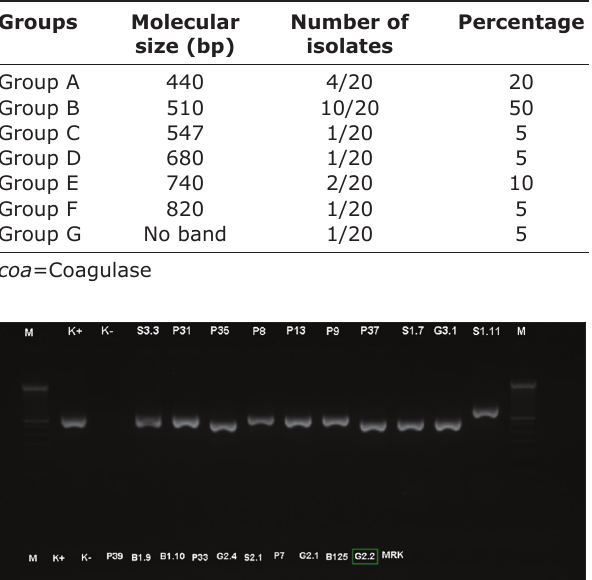
Table-2: Group of isolates based on coa gene amplification product size.